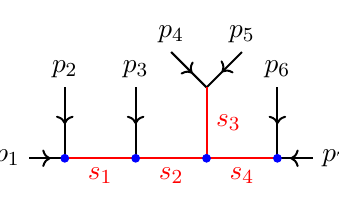
Figure 2. Auxiliary momenta and Mandelstam variable assignments: graphical representation of the 7 -point conformal block in the mixed channel from figure 1b with auxiliary momenta and Mandelstam variables